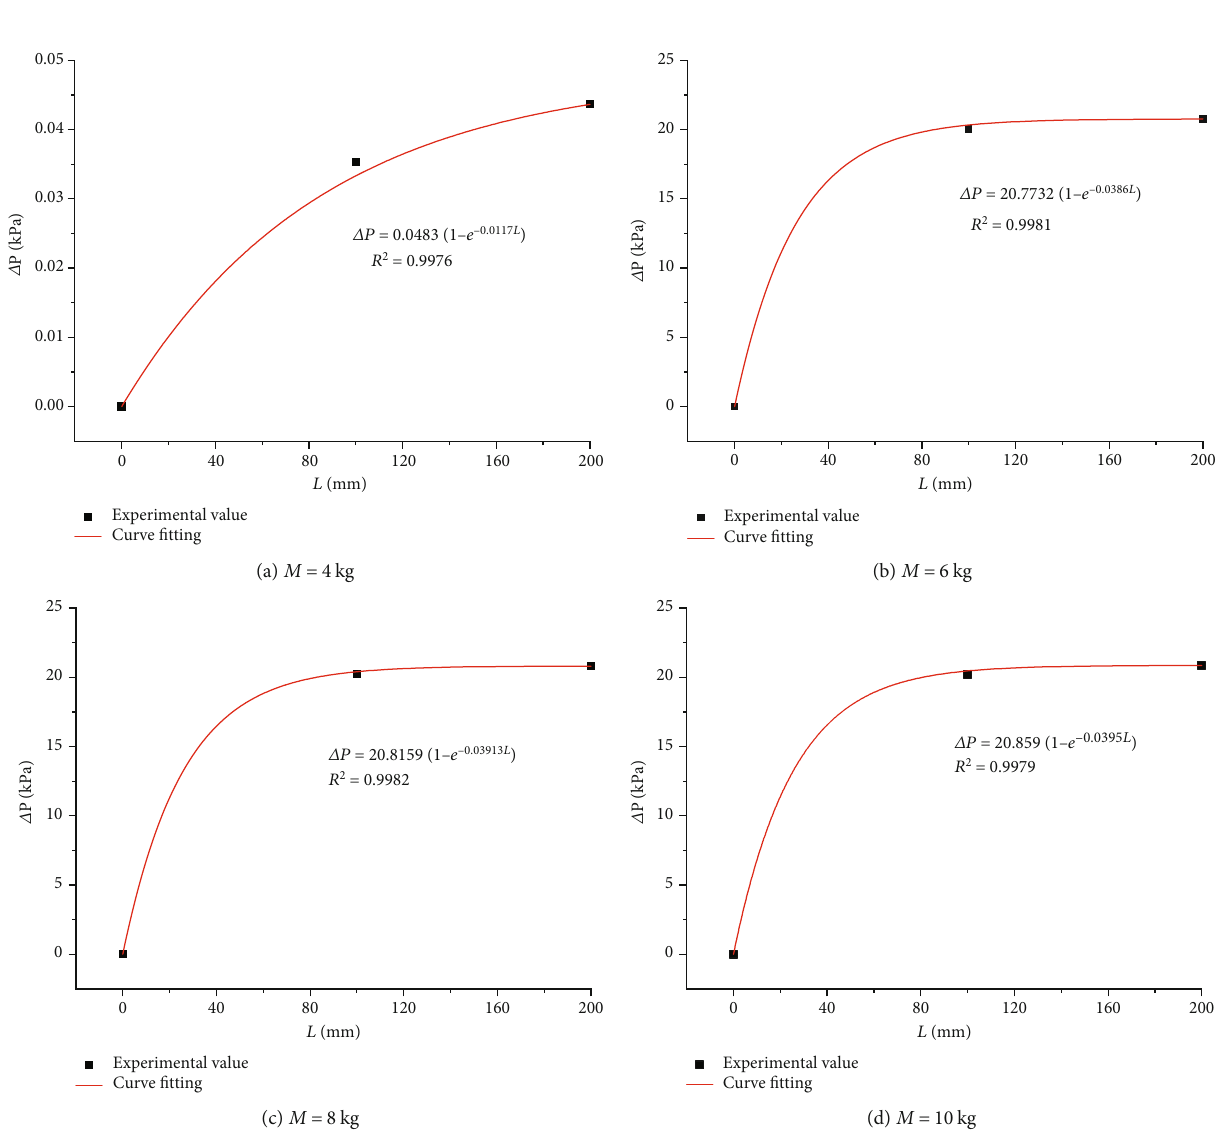
Figure 6: Relationship between pore water di ff erence Δ P and distance L ð F = 2 B Þ